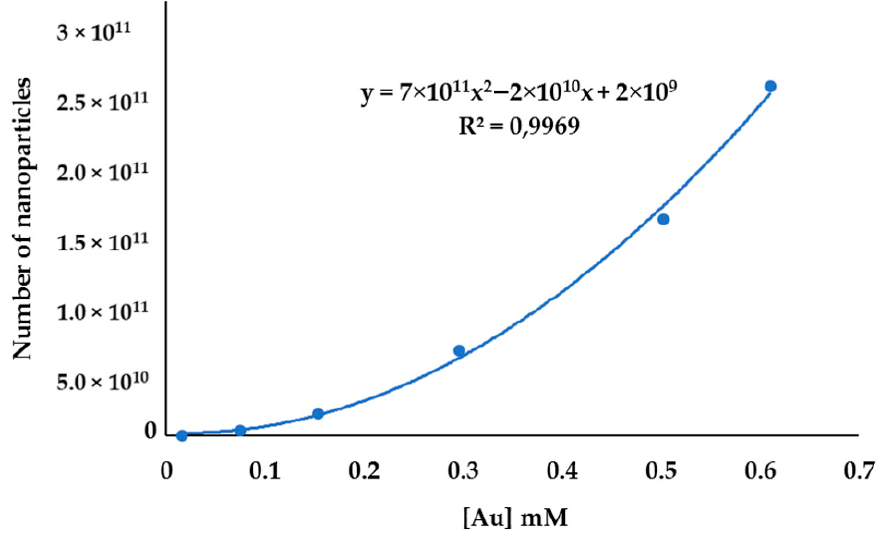
Figure 11. Number of AuNPs at different concentration levels.